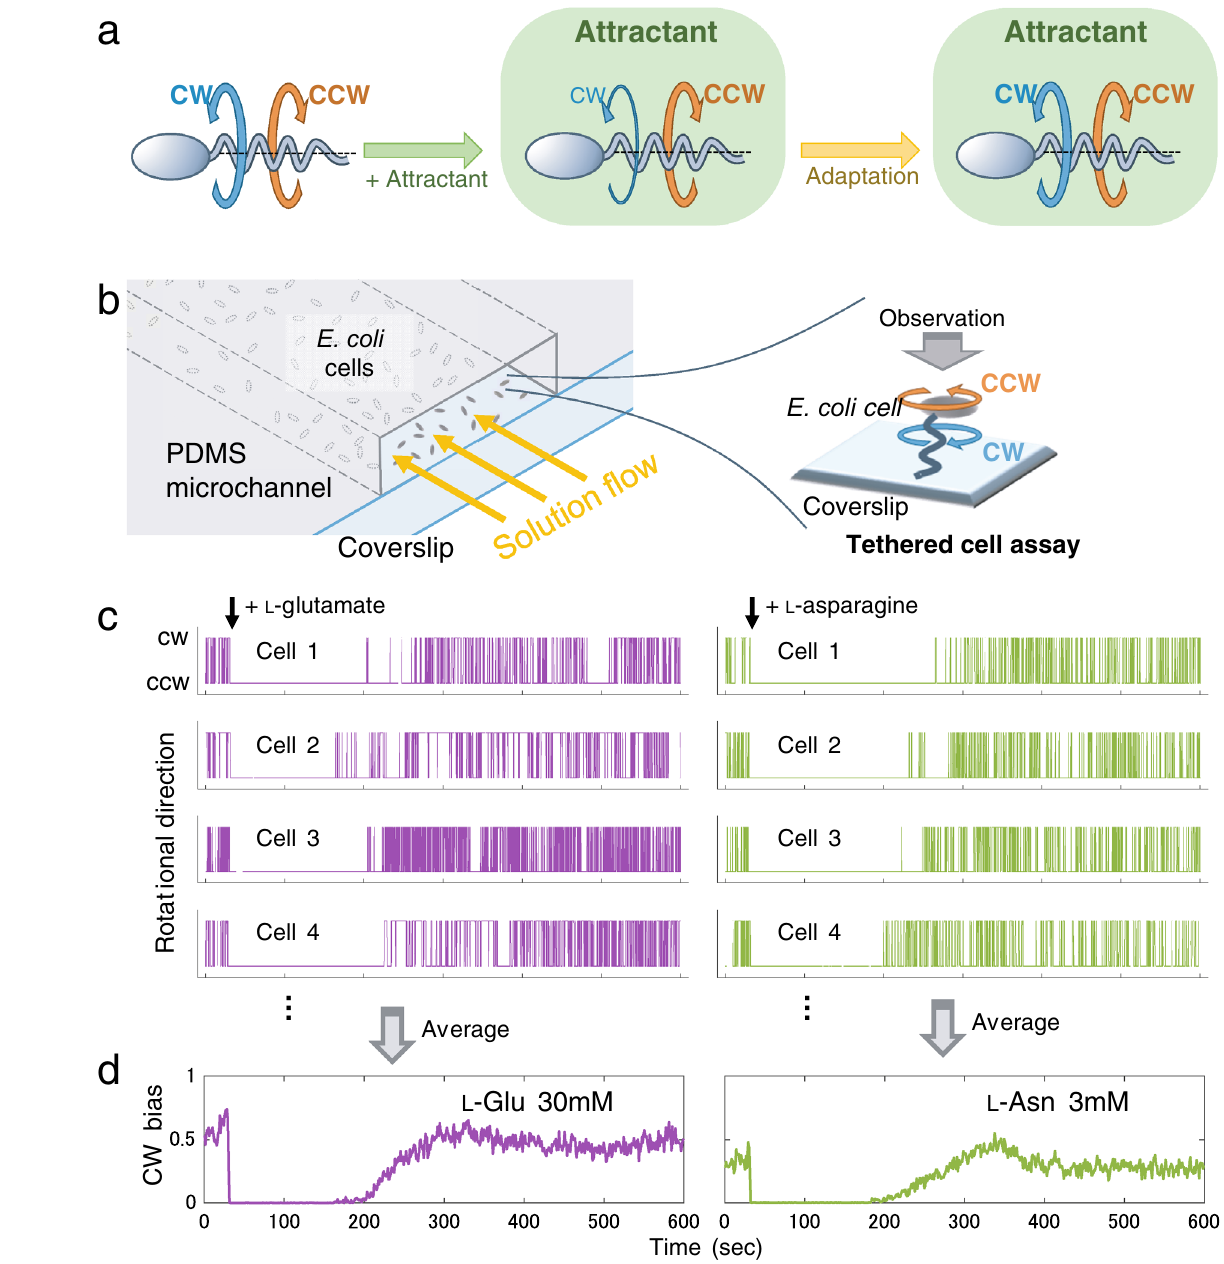
Figure 1. Experimental design. ( a ) Each flagellar motor of E. coli cells in steady state environment shows bi-directional motions stochastically (CW or CCW direction). When an attractant is added to the environment (chemical stimulus), cells detect differences in the amount of the attractant and bias flagellar rotation in the CCW direction. After a sufficient time (~ 400 s in case of c , d ), under constant concentrations of attractants, each flagellar motor recovers bi-directional motion (adaptation). ( b ) Schematic drawing of the experimental setup (left) and tethered cell assay (right). Each experimental chamber consisted of a PDMS microchannel on a coverslip. E. coli cells applied to a chamber were adhered to a glass surface via cell bodies and/or flagella. The rotational motion of cell bodies, each tethered via flagellum by chance, was analysed. ( c ) Rotational directions of individual cells. Cells were stimulated by (left column) l-Glu (30 mM) and (right) l-Asn (3 mM). Vertical axes show the rotational directions (CW or CCW). Horizontal axes are common to ( d ) and represent time. Arrows indicate the times of chemical stimulations. We measured rotational motions of cells at every 10 ms (1 frame of our movies), and counted those more than 7.5 degrees/frame, which was more than two times larger than that of noise (< 3 degrees/frame). Most of cells rotated CCW immediately after chemical stimulation (attractant response) and recovered bi-directional rotations as in the initial phase over time (adaptation). Individual cells had varied response time courses. ( d ) Ensemble averages of rotational directions of cells. Vertical axes represent the CW bias, which was calculated as the fraction of CW motion (number of CW rotations) to all rotational motions (number of CW + CCW motions) at 1-s intervals. The motions of more than 100 of approximately 500 observed cells were